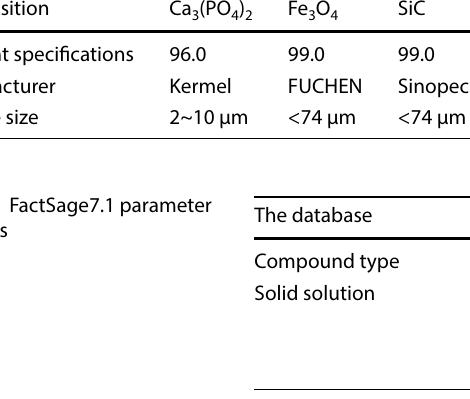
Table 1 Reagent types and specifications (wt.%). Composition